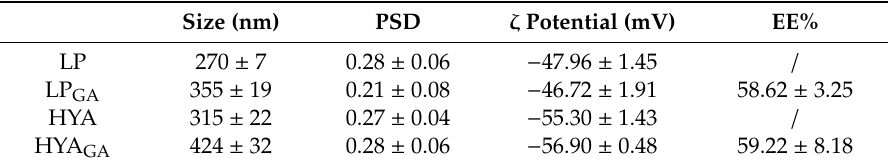
Table 1. Size (nm), particle size distribution (PSD), ζ potential (mV), and encapsulation e ffi ciency (EE %) of the di ff erent vesicles. HYA, hyalurosome; LP, liposome; GA, glycyrrhetinic acid. Size (nm) PSD ζ Potential